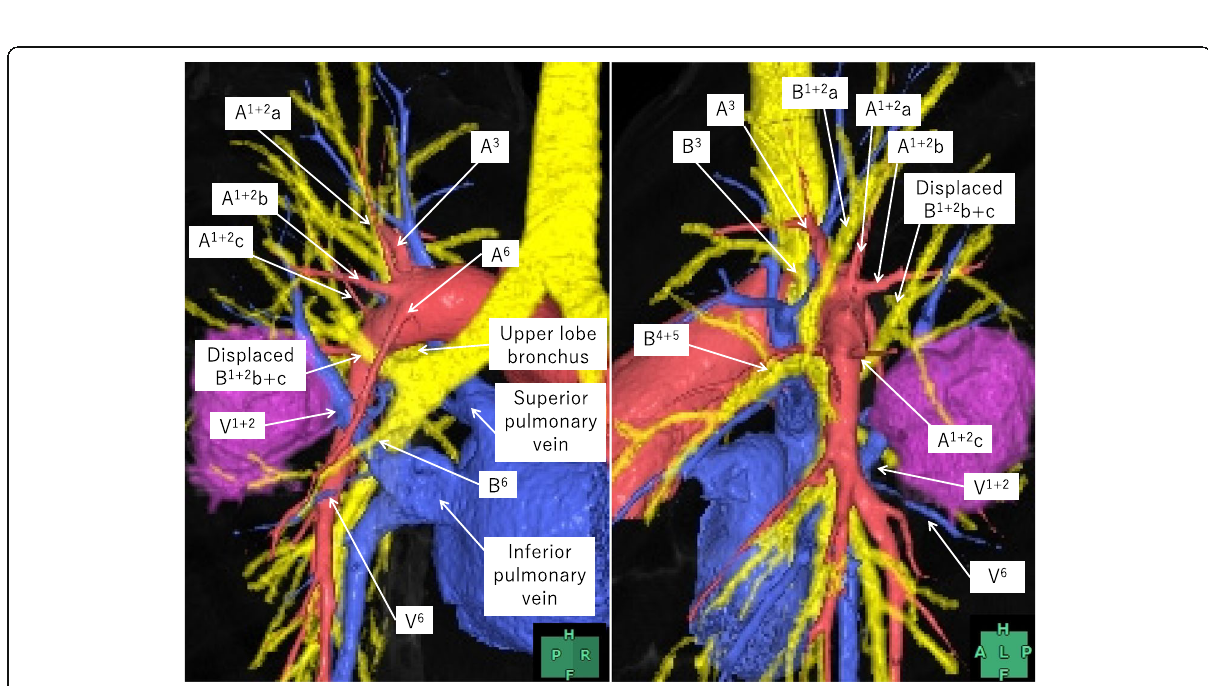
Fig. 3 Three-dimensional computed tomography with multiplanar reconstruction. The displaced B 1+2 b+c passes to the dorsal side of the left main pulmonary artery. The branch of A 6 arises from the left main pulmonary artery at the level of the branches of A 3 and A 1+2 and passes to the dorsal side of the displaced B 1+2 b+c. The branch of V 1+2 passes between B 6 and the bronchus to the basal segment and joins V 6 at the dorsal side of the pulmonary hilum